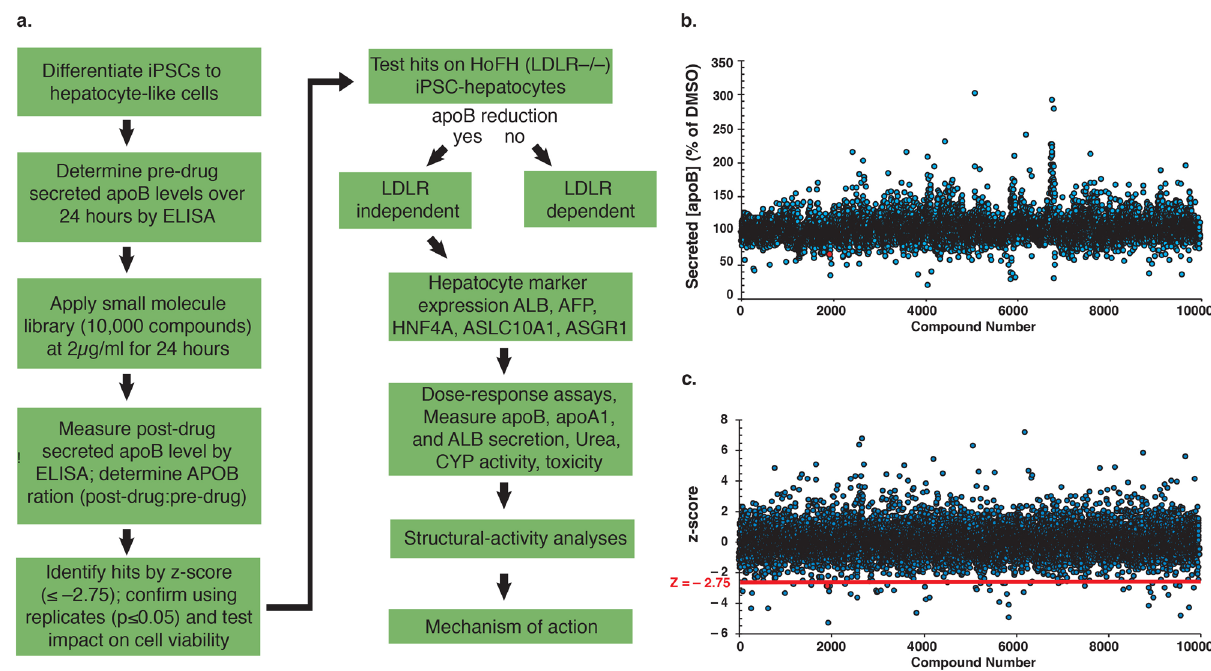
Fig. 1 A small molecule screen using human iPSC-derived hepatocytes. a Schematic overview of the procedure used to identify compounds that reduce apoB produced by human iPSC-hepatocytes. b Graph showing post-drug: pre-drug ratios ( Δ [apoB]) in the medium of apoB in compound-treated compared to DMSO-treated iPSC-hepatocytes (% DMSO). The blue dots represent each individual compound from the SC 3 library 10 K representative set. c Graph showing the z score of each individual compound (blue dots) on the post-drug: pre-drug apoB ratio. Red dot is DL-1. Red line indicates the z-score at a value of – 2.75 ( z = – 2.75).